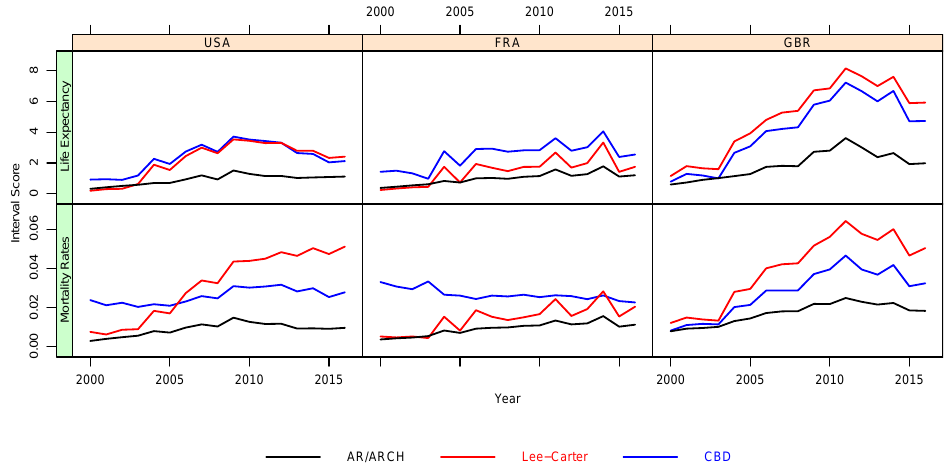
Figure 8. Confidence interval forecast score: The mean interval score across ages for different forecasting years for the LC, AR-ARCH, and CBD two-factor